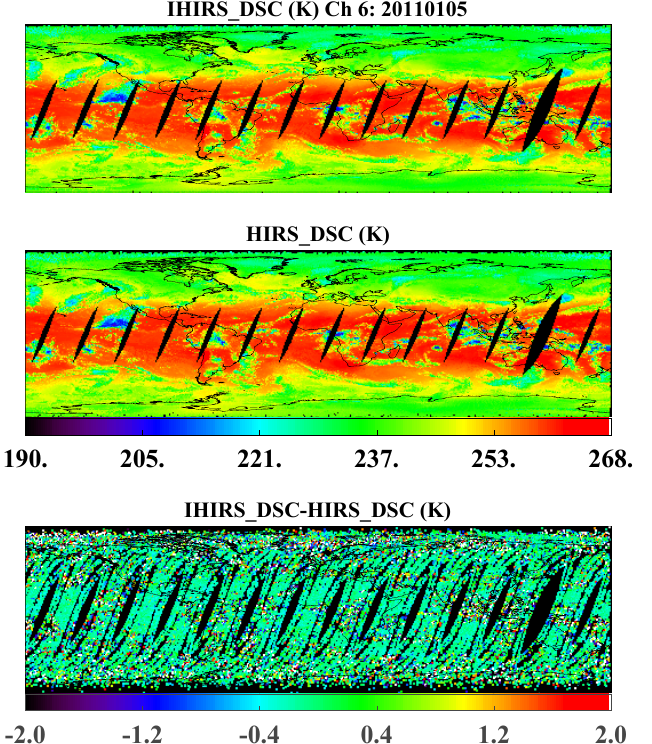
Figure 5. Same as Figure 4, but for channel 12.